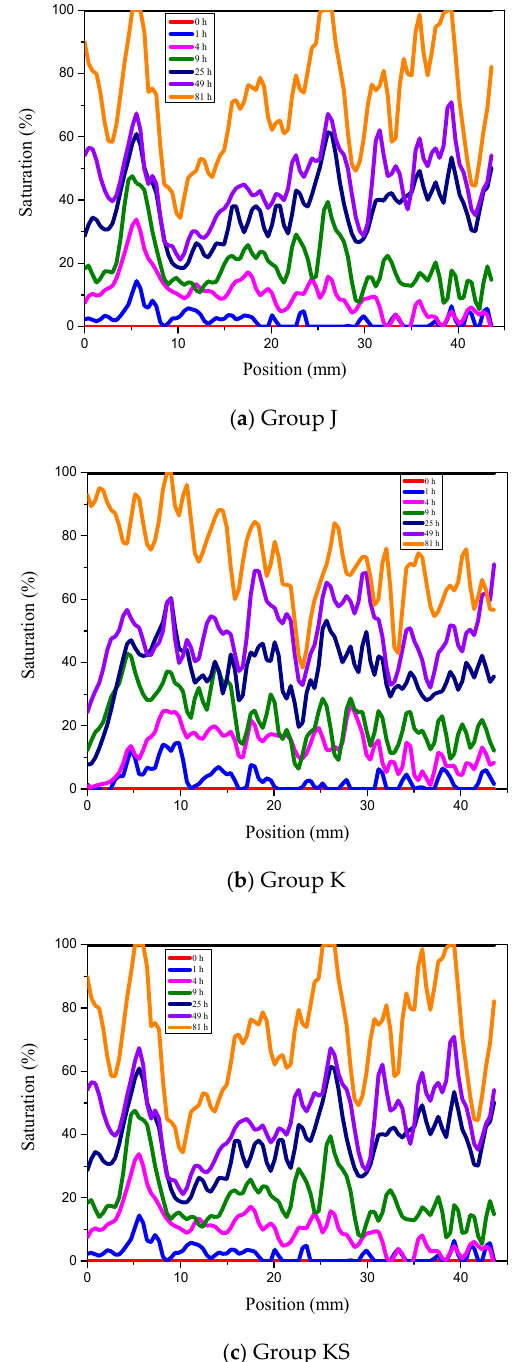
Table 5. 𝐷 (cid:2868) values of exponential and power functions.